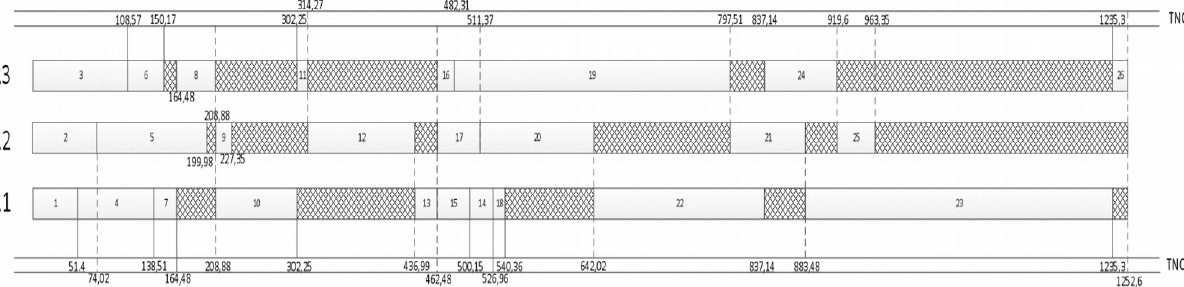
Figure 9. Gantt Chart for the ACTIM Scheduling (Scenario